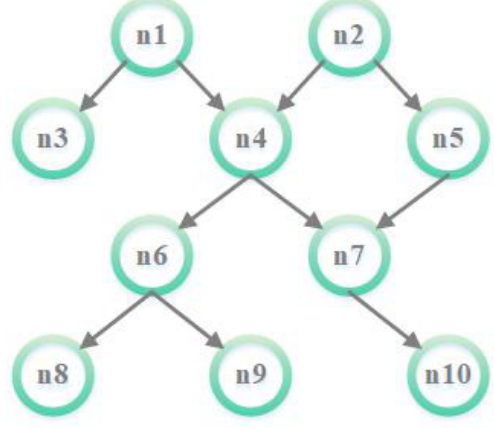
Figure 3. A topology representation of task